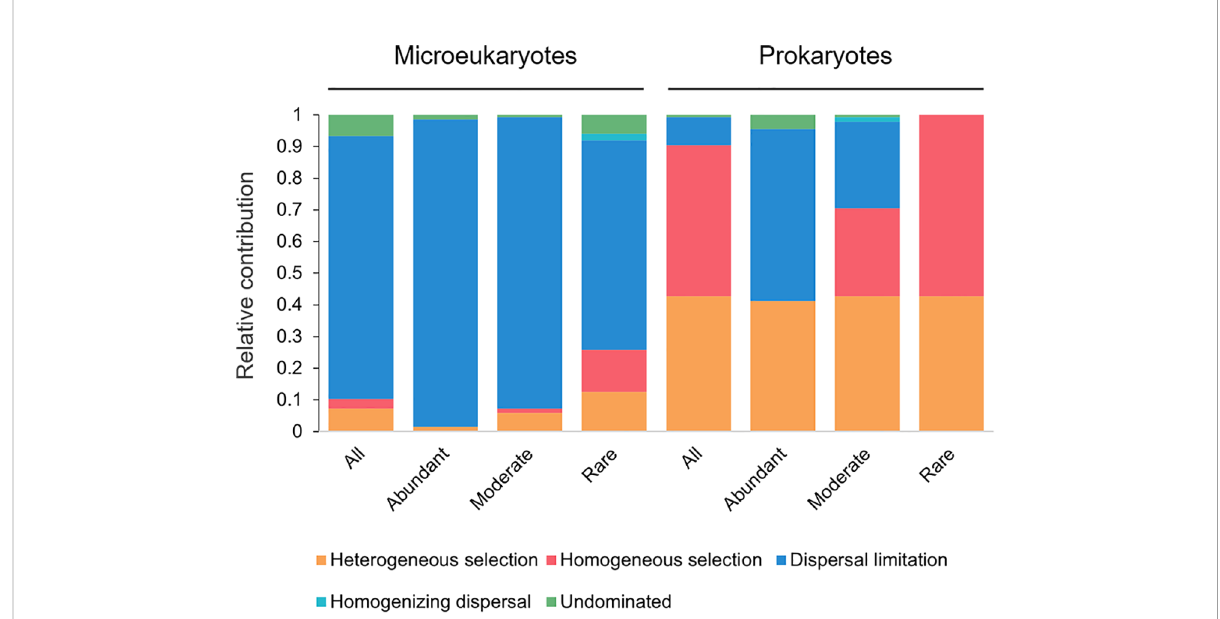
FIGURE 6 The relative contributions of the ecological processes in shaping plankton microbiome. Abundant, Moderate and Rare indicate the abundant, moderate and rare plankton subcommunities,